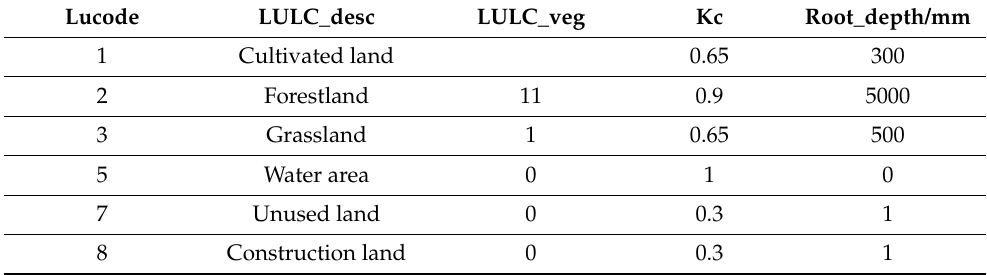
Table 1. Biophysical parameters used for the InVEST water yield model. Lucode